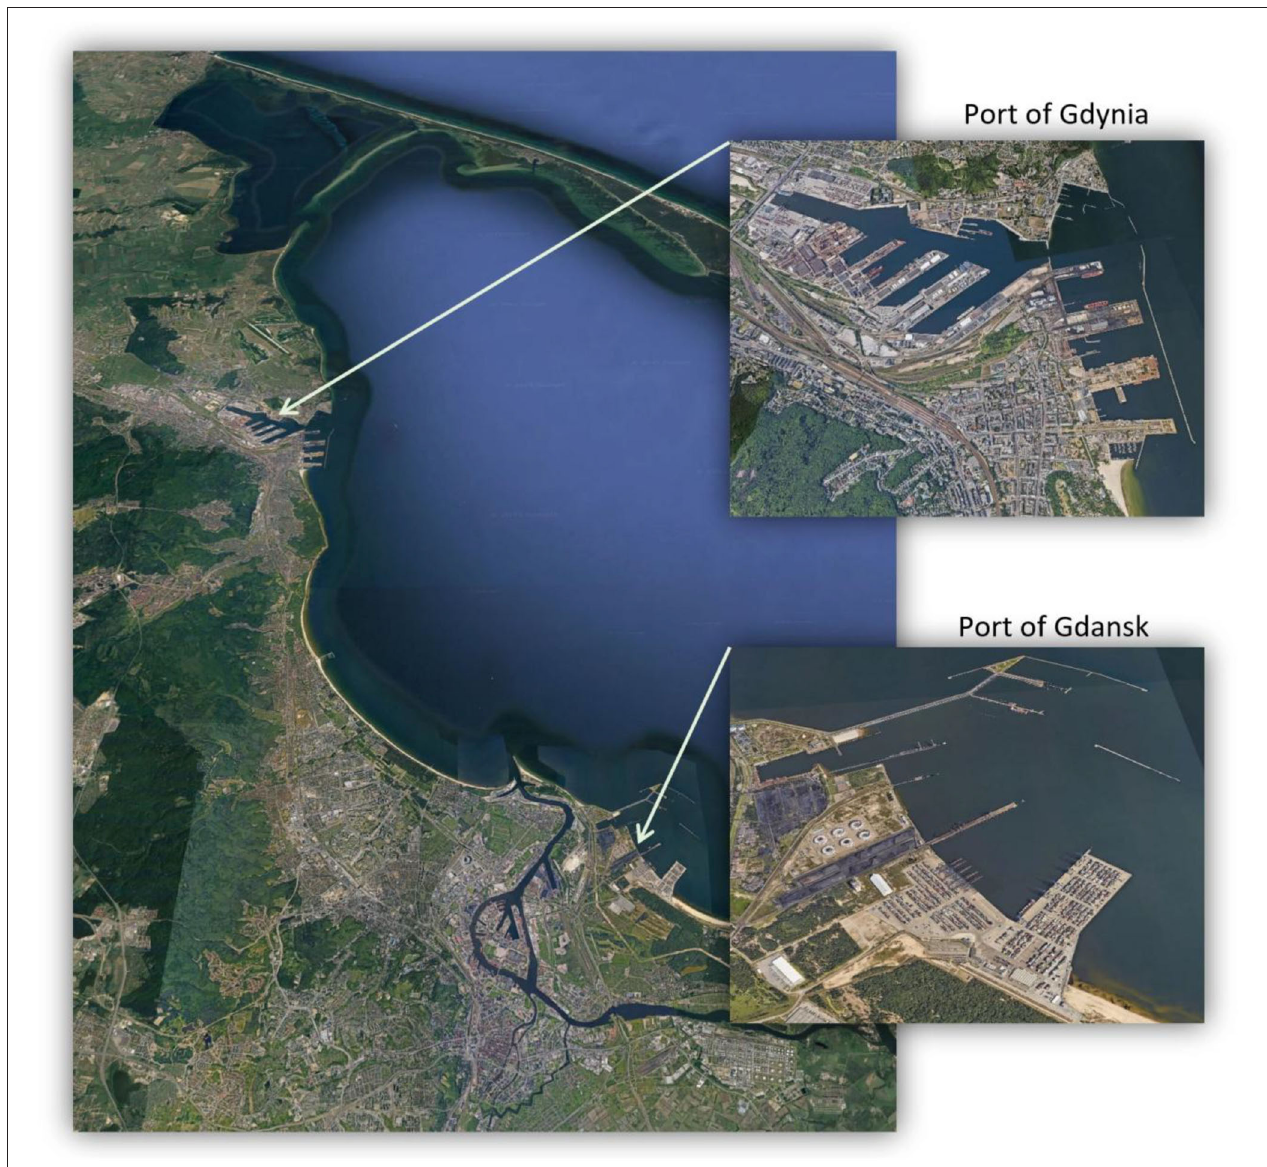
FIGURE 1 | Tri-city agglomeration, consisting of two seaports. Source: Google Earth,